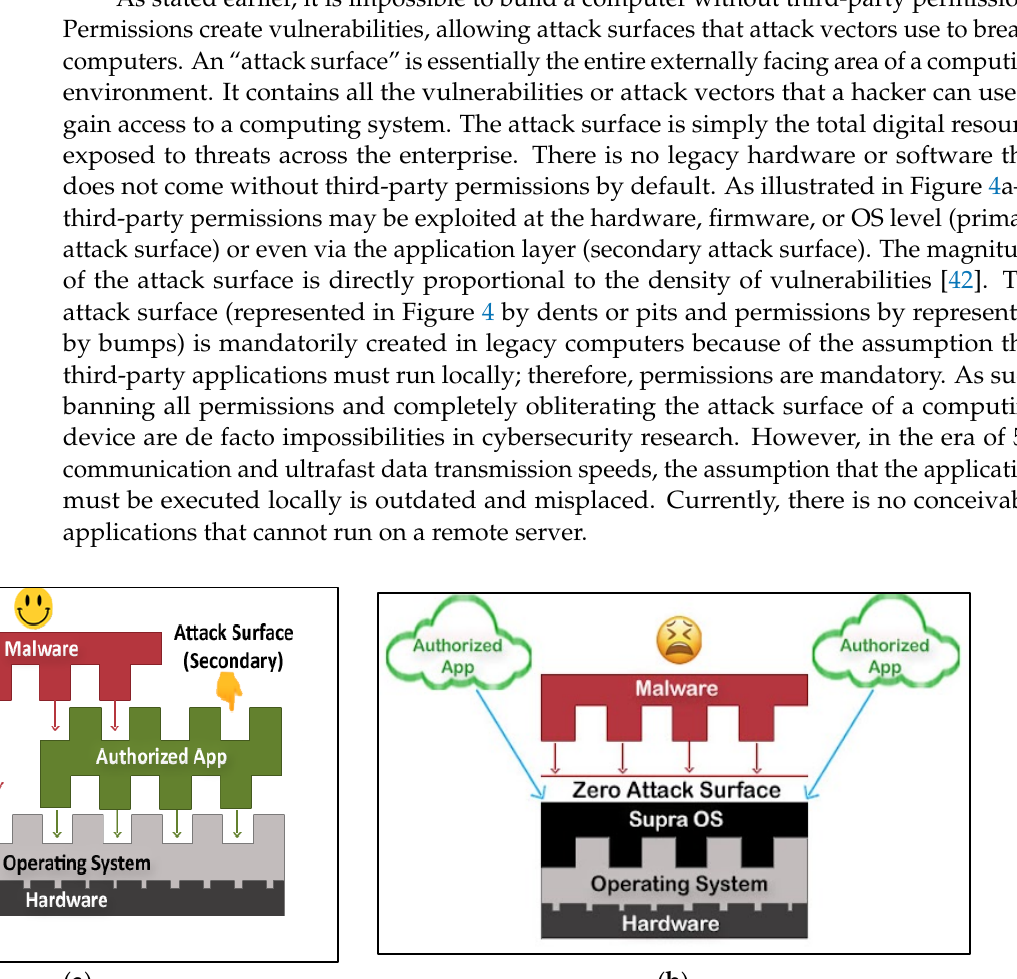
( f ) Figure 4. ( a ) In the traditional computing system, the third-party permissions create primary and secondary attack surfaces that bad actors exploit to breach the computer. ( b ) Zero vulnerability computing (ZVC) completely obliterates the attack surface to achieve a zero attack surface. ( c ) Conceptual diagrammatic representation of primary and secondary attack surfaces. ( d ) Diagram- matic representation of SOS obliterating the attack surface and providing a web interface. ( e ) ICOS with a soft switch and LED indicator. ( f ) ICOS operation with a hard toggle switch. 5.2. The Innovation Considering these realities of the prior state-of-the-art, our SOS hypothesis chal- lenges the very foundation of legacy computer design by banning all permissions for na- tive installation/execution of third-party applications, while allowing only remotely served applications, as illustrated in Figures 4b,d and 5, via a built-in web interface that does not in any way depend on nor communicate with the host computer’s operating system. In other words, the ZVC ecosystem runs on its own: it is self-sustaining, running on its own minimalist operating system and has no dependencies on the host operating system. In legacy systems, it is normal to expect any software application to create its own at- tack surface because of the permissions it avails from the OS, firmware, or hardware and inadvertently passes it on as an indirect permission (zero-day vulnerability) to the adver- sary. Since ZVC allows only Internet-delivered applications, there is no need for running native applications or a need for third-party permissions that create an attack surface.